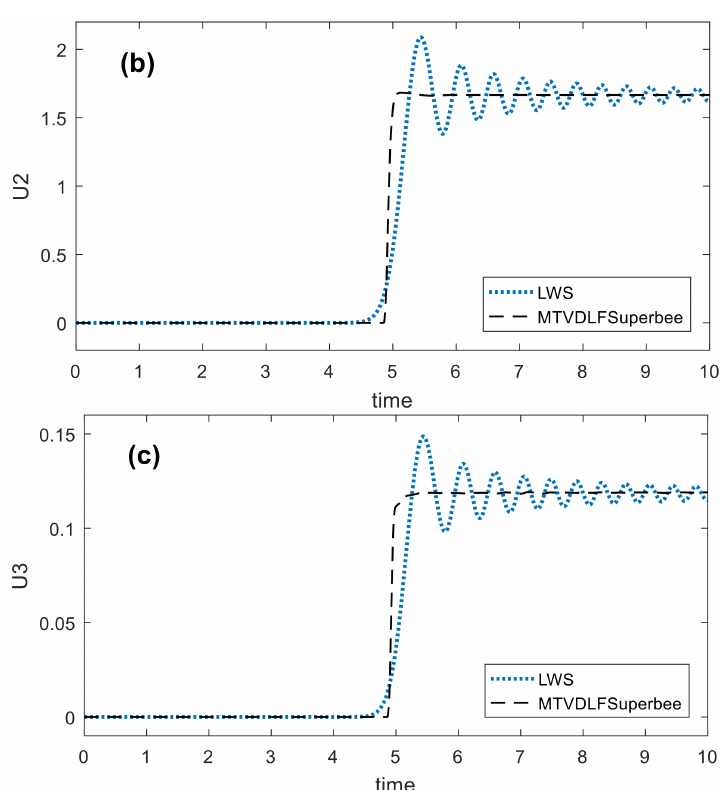
Figure 6. Comparisons of LWS and MTVDLF-Superbee scheme for autocatalytic reaction model with three-component reactants at X = 0.5 with V = 0.1. Concentration distribution along the reactor for